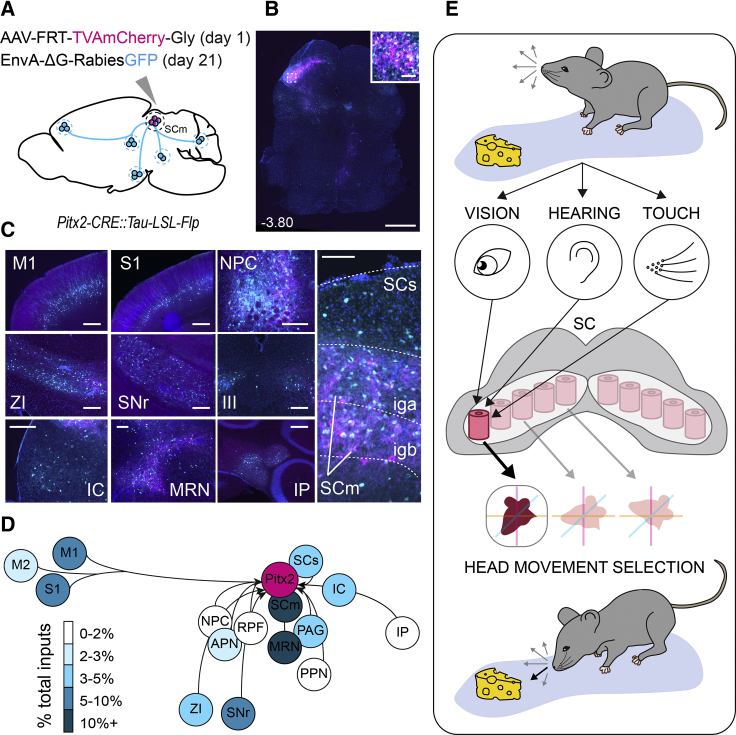
Pitx2ON Modules Form a Site of Convergence for Sensory and Motor-Related Information(A) Brain-wide pre-synaptic input to Pitx2ON neurons in Pitx2-CRE::Tau-LSL-FLPo-INLA mice revealed through the selective targeting of Pitx2ON neurons via a FLP-dependent AAV expressing TVA-Gly (magenta, TVAmCherry) followed by EnvA-ΔG-RabiesGFP (cyan, GFP) injection.(B and C) Overview of targeted neurons (B) (scale bar: 1 mm, inset: 100 μm) and their presynaptic cortical and subcortical partners (C) (scale bars: 250 μm).(D) Relative contribution of distinct brain regions to the presynaptic network of Pitx2ON neurons (nMICE = 3). Input areas are M1, primary motor cortex; M2, secondary motor cortex; S1, primary somatosensory cortex; ZI, zona incerta; NPC, nucleus of the posterior commissure; APN, anterior pretectal nucleus; SNr, substantia nigra pars reticulata; III, oculomotor nucleus; SCs, superior colliculus, sensory related; SCm, superior colliculus, motor related; MRN, midbrain reticular nucleus; PAG, periaqueductal gray; PPN, peduncolopontine nucleus; IC, inferior colliculus; IP, interposed nucleus.(E) Schematic summary of the selection of orienting movements in the mouse SC. Multimodal stimuli (vision, hearing, touch), coming from the environment, converge to recruit specific Pitx2ON neuronal modules in the SGI (pink barrel). The SGI integrates the incoming signals and orchestrates the selection of appropriate Pitx2ON modules according with a motor map (black arrow). Activation of Pitx2ON neurons generates spatially targeted head movements.See also Figure S3.